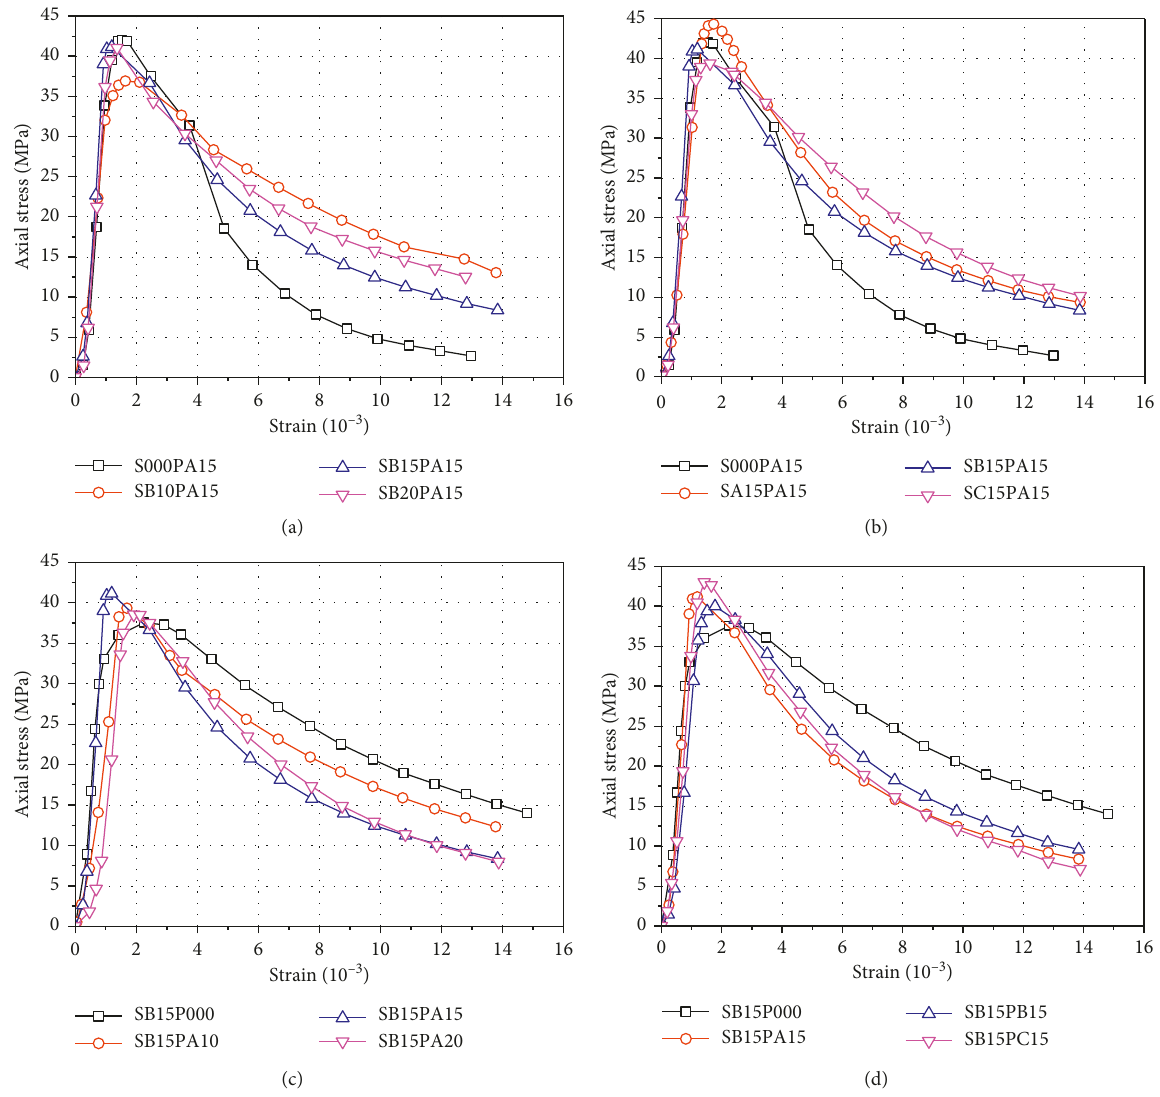
Figure 8: Envelope curves of BFRC specimens for different fiber volume fractions and aspect ratios. (a) Effect of volume fraction of SF. (b) Effect of aspect ratio of SF. (c) Effect of volume fraction of PF. (d) Effect of aspect ratio of